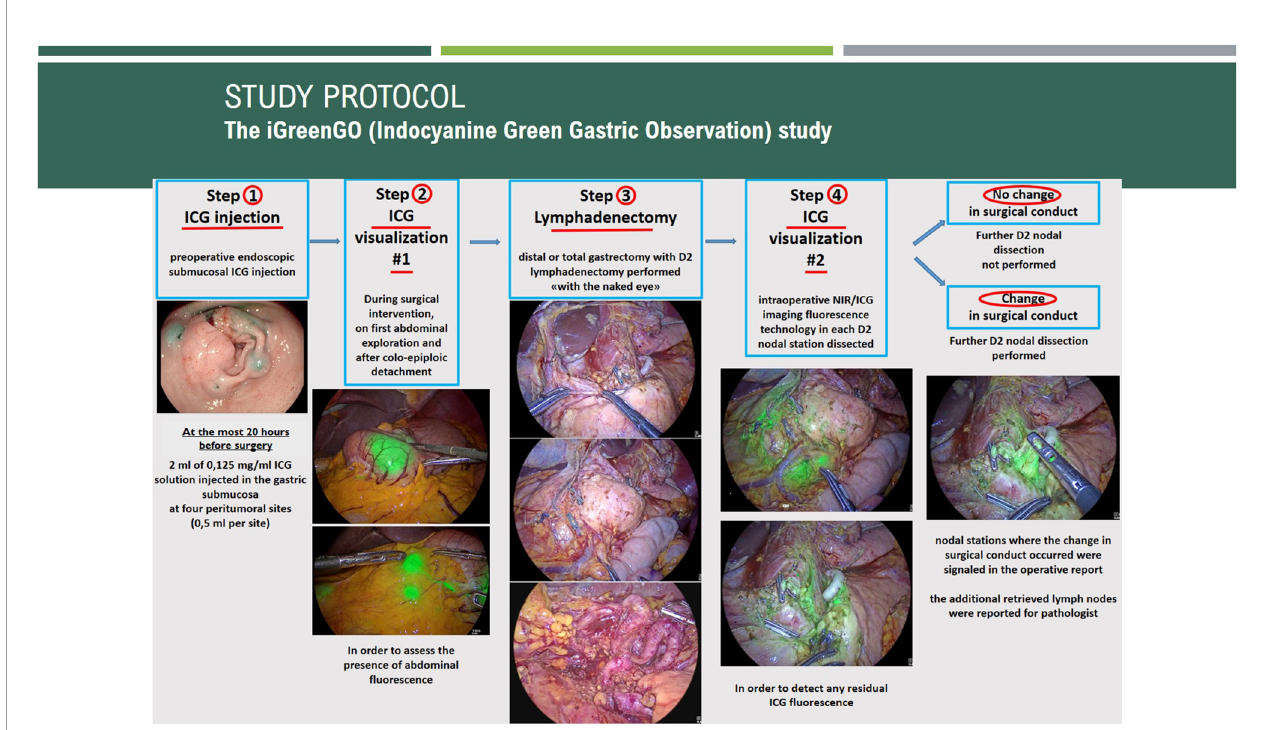
FIGURE 1 | Summary steps of the iGreenGO study. NIR/ICG, near-infrared/indocyanine